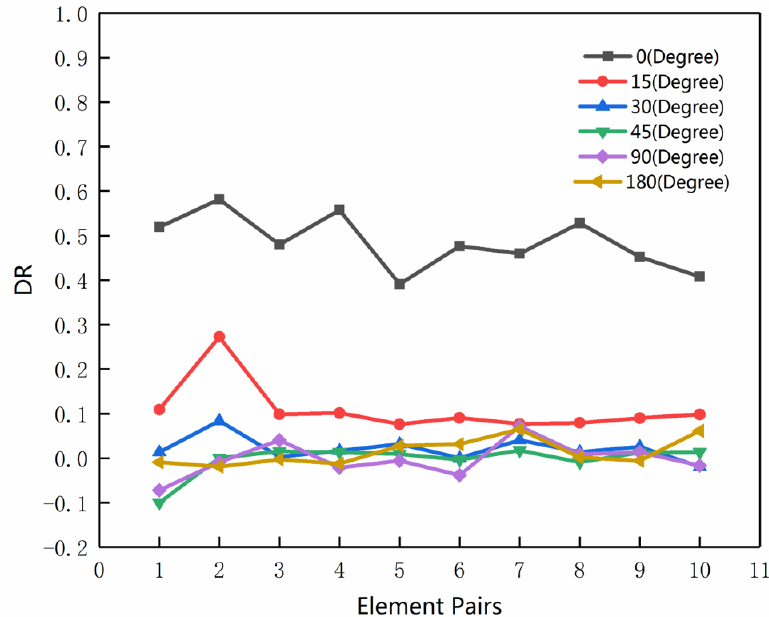
Figure 21. DR of 10 pairs of elements with the same name under different rotation angles by using PRM.